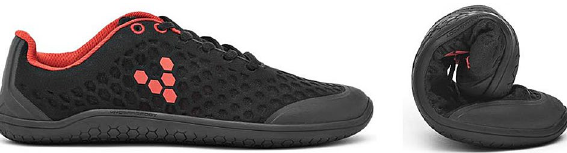
Figure 1. Lateral views of the minimal footwear used in the intervention study (Vivobarefoot Stealth II). Image: Vivobarefoot (with permission).